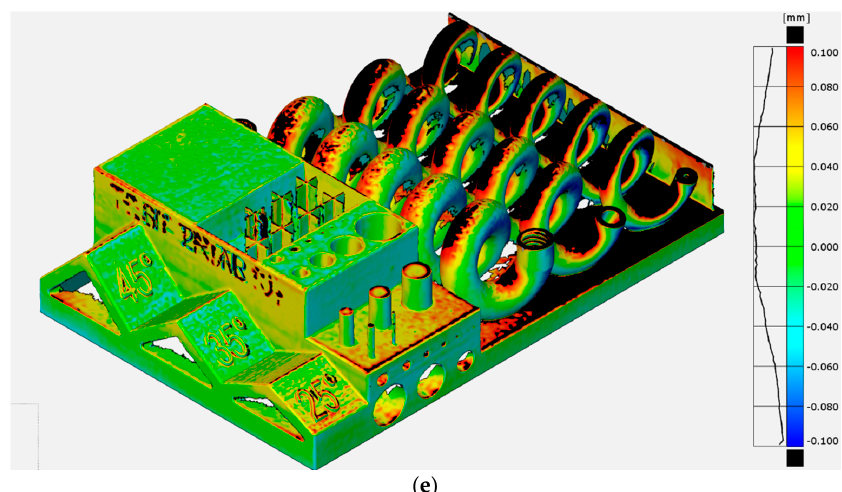
Figure 14. Color plot from the entire second job from company H; 3D scanner top alignment. ( a ) BL, ( b ) BR, ( c ) C, ( d ) TL, ( e ) TR.